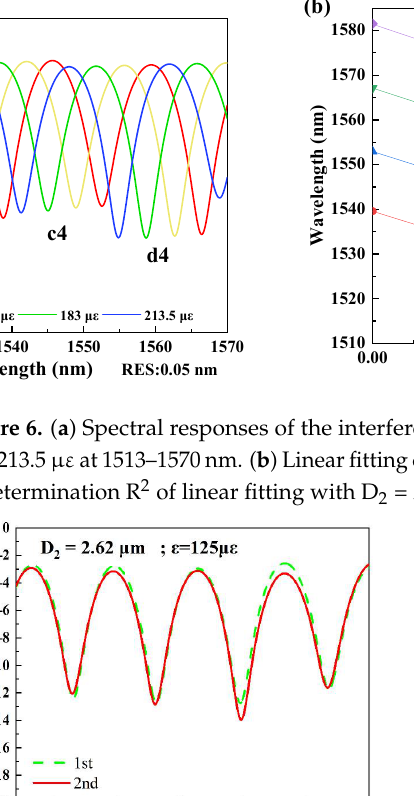
cients of determination R 2 of linear fitting with D 2 = 4.49 μm.